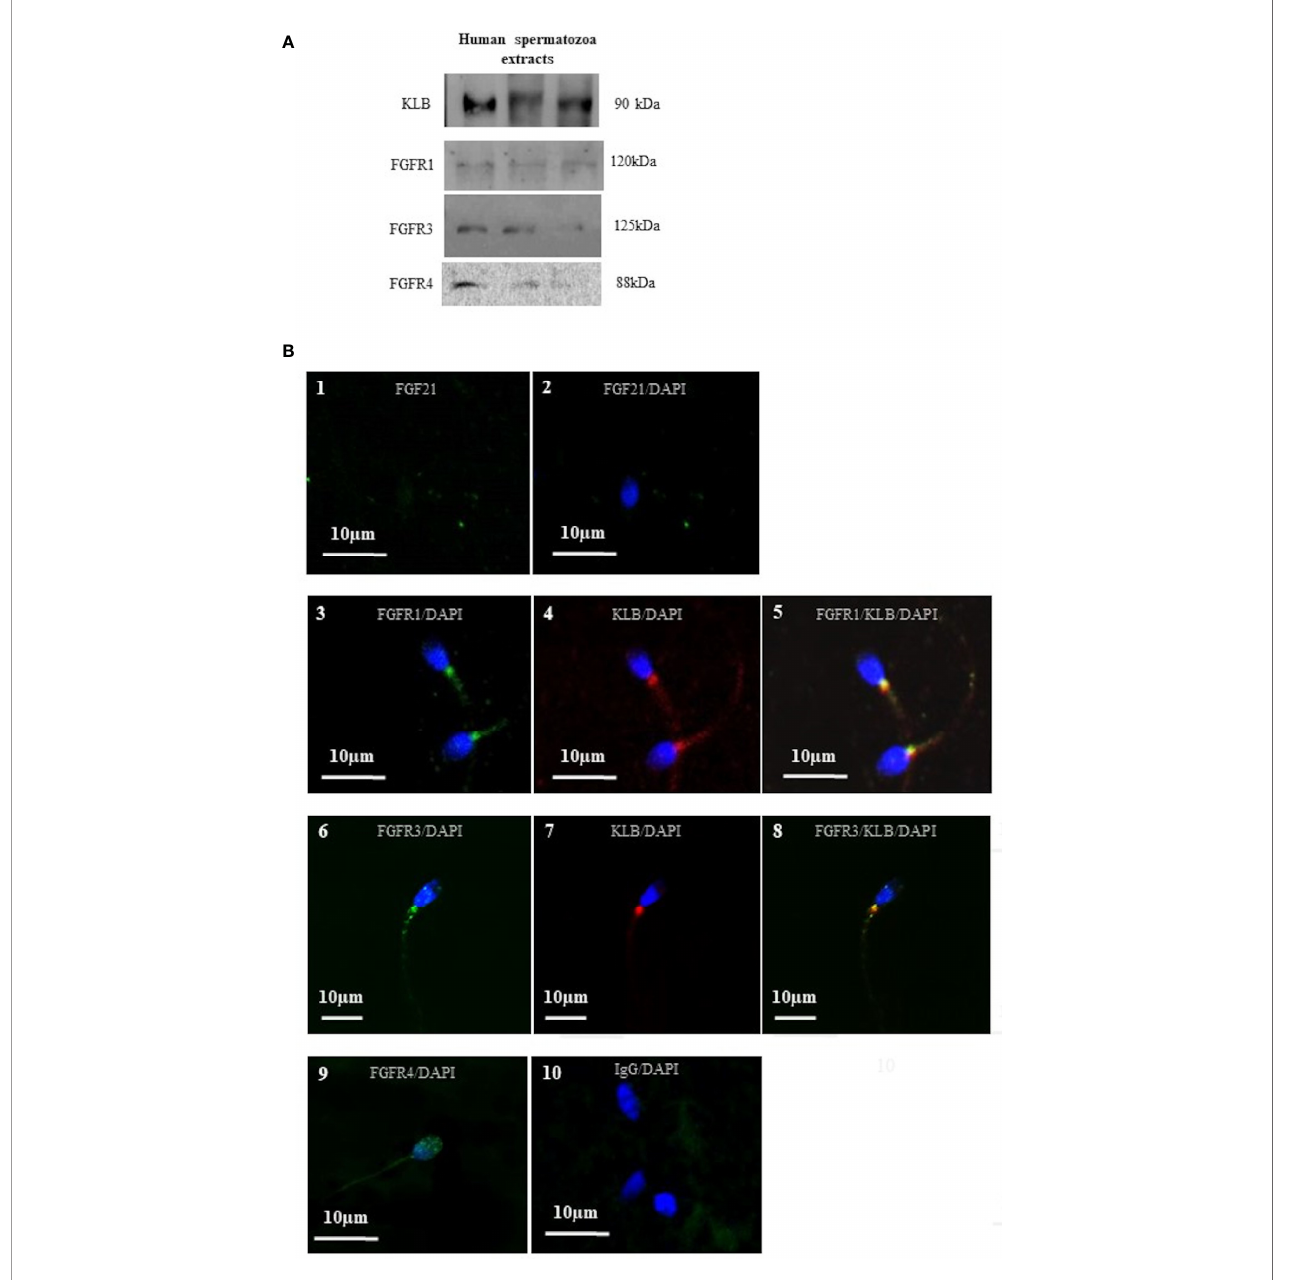
FIGURE 3 | Localization of FGF21 receptors on human spermatozoa. (A) Detection of sperm cofactor KLB and the FGFR1, FGFR3, and FGFR4 using Western immunoblotting. Red ponceau was used to check protein deposition on the membrane. Each lane represents extracts from different donors. Receptors and cofactor were tested on different gels. (B) FGF21 (1 and 2), FGFR1, FGFR3, FGFR4 (3, 6, and 9), and KLB (4 and 7) localization in human spermatozoa were analyzed by confocal microscopy after immuno fl uorescence. FGFR1, FGFR3 and FGFR4 were stained by Alexa Fluor 488 goat anti-rabbit IgG (green) and KLB (4 and 7) by Alexa Fluor 633 rabbit anti-mouse IgG (red). Merged picture of FGFR1 and FGFR3 with KLB showing the colocalization in the mid-piece of spermatozoa (5 and 8). Negative control was incubated with IgG (10). DNA was counterstained with